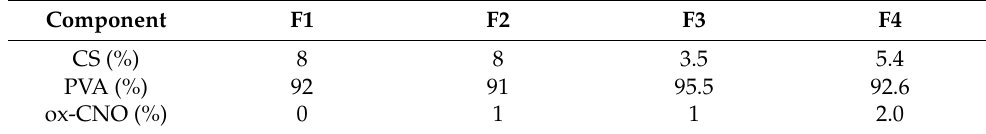
Table 4. Formulation composition of nanocomposites